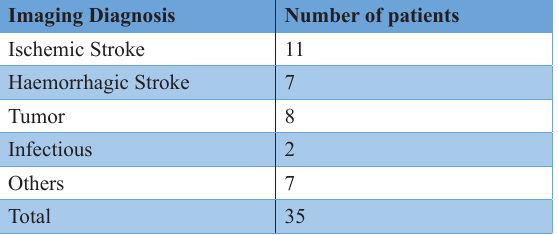
Table 2. Imaging characteristics of the patients with non- trauma Imaging Diagnosis